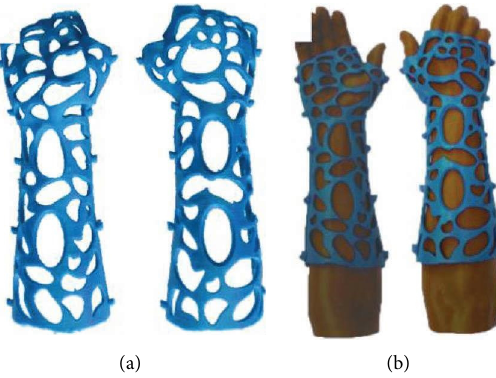
Figure 3: (a) PLA-printed prototype. (b) Assembly of the prototype with the model of the arm.